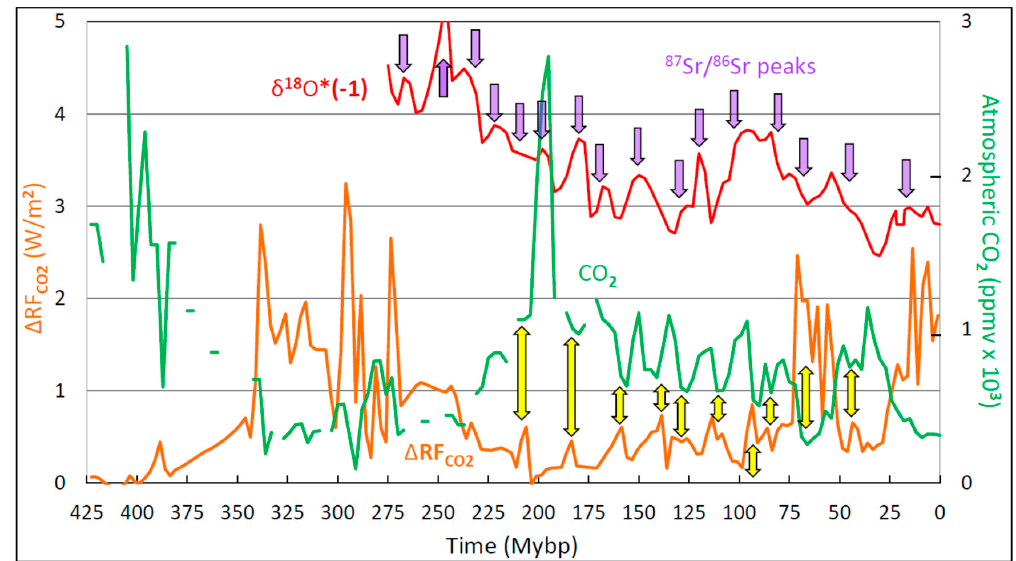
Figure 11. Time series of temperature proxies, atmospheric CO 2 concentration and Δ RF CO2 over the Phanerozoic Eon. Purple arrows correspond to peaks in the strontium ratio determined independently from visual inspection of time series in [28]. Temperature proxies (red curve) are from Prokoph et al. [28]. CO 2 proxies (green curve) are from Royer [40], represented here using a 3–6 My moving average. Yellow double-headed arrows highlight the expected antiphasic relationship between atmospheric CO 2 concentration and marginal forcing computed for tropical latitudes under clear-sky conditions. The scale for the temperature proxy is modified here by a constant offset for graphical presentation on the same scales as the other proxies. The correct temperature-proxy scale is shown in Figure 5. In this and following graphs, climate variables are color-coded: red represents the temperature proxy, δ 18 O*( − 1); green represents atmospheric CO 2 concentration proxies converted to ppmv; and orange represents the marginal forcing calculated for each atmospheric CO 2 concentration datapoint using the best-fit power function equation corresponding to the empirical curve for tropical latitudes under clear-sky conditions (Figure 8b).